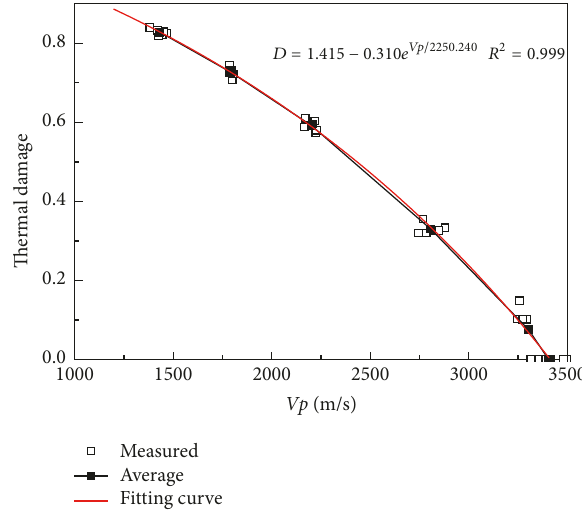
Figure 5: Relation of ultrasonic P-wave velocity after high temper- ature treatment with temperature.